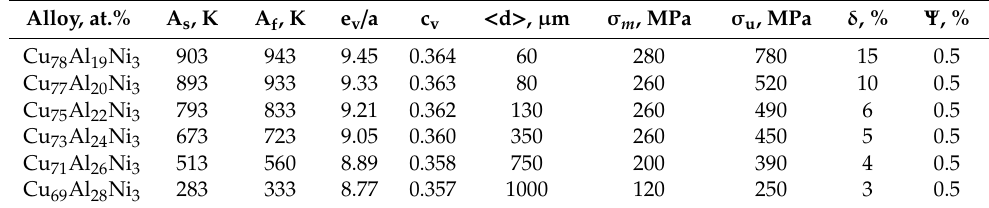
Table 4. A s and A f of TMT, the number of valence electrons per atom e v / a, and their concentration c v , average grain size < d > and mechanical properties of Cu–Al–Ni-based